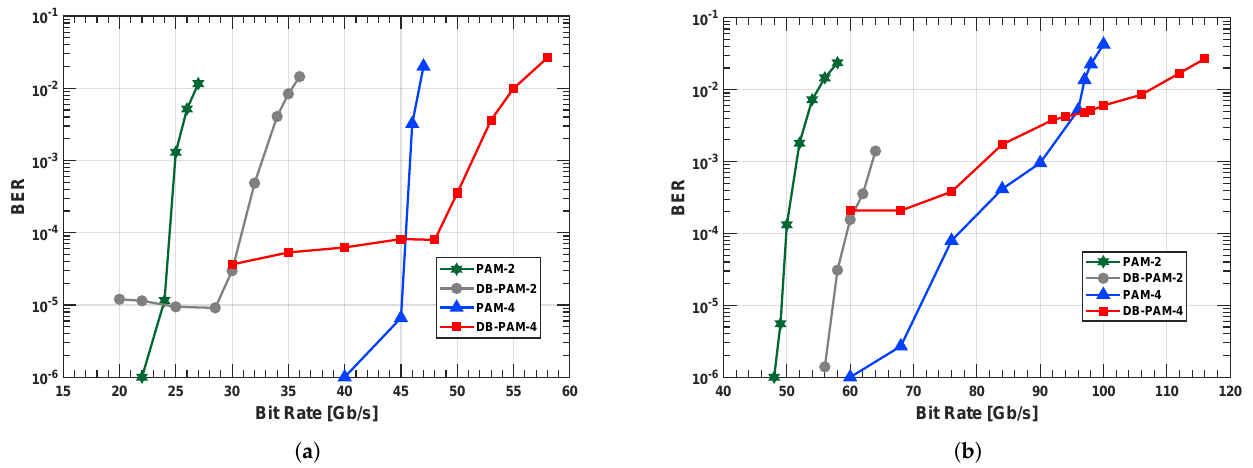
Figure 6. Measured BER as a function of bit rate for the ( a ) low BW (3-dB receiver BW of 7.3 GHz) and ( b ) high BW (3-dB receiver BW of 15.3 GHz) systems in BtB configuration using PAM-2,4 and DB-PAM-2,4 modulation